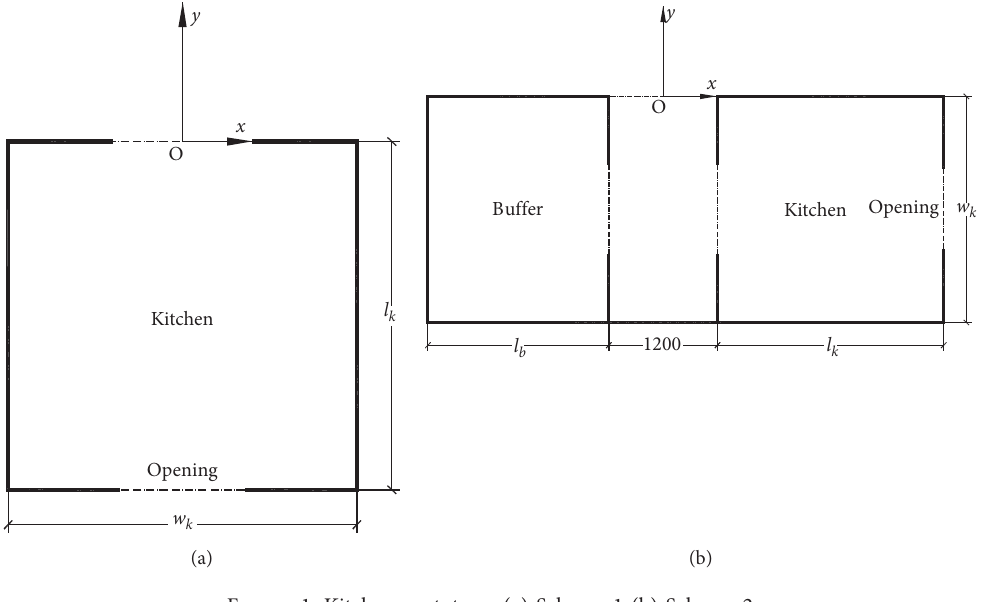
Figure 1: Kitchen prototype. (a) Scheme 1 (b) Scheme